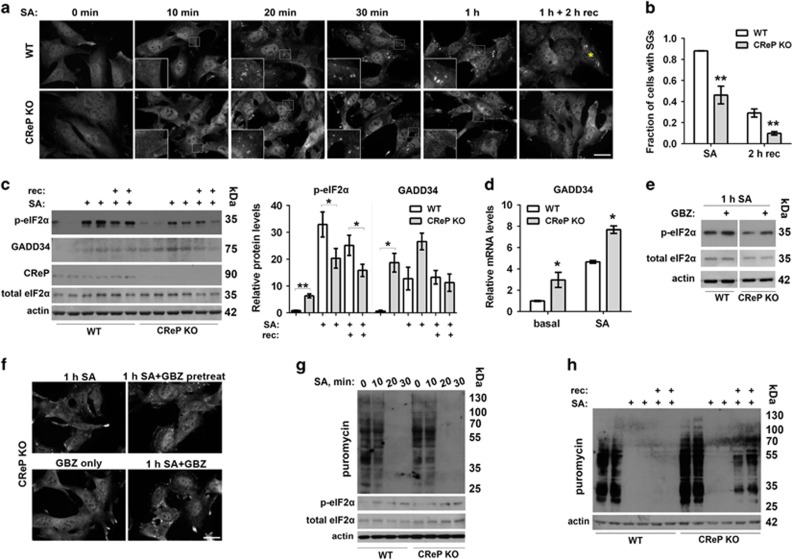
CReP KO MEFs characterized by chronically elevated basal p-eIF2α levels are deficient in SG assembly. (a and b) Initial stages of SG assembly are not affected but SG assembly cannot be maintained through the entire duration of stress in CReP KO cells. WT and CReP KO MEFs were treated with SA for the indicated times. Representative images of TIAR-positive SGs are shown. An asterisk indicates a cell with SGs after 2 h of recovery (a). The fraction of cells with mature SGs was quantified immediately after 1 h of SA and after 2 h of recovery (n=3, **P<0.01) (b). Scale bar, 10 μm. (c) CReP KO MEFs display elevated basal p-eIF2α but fail to maintain high p-eIF2α levels during stress and recovery. Cells were treated with SA for 1 h or left to recover for 30 min after SA wash-off. Representative western blots and band intensity quantification are shown (n=6, *P<0.05, **P<0.01). (d) GADD34 mRNA level is increased in CReP KO MEFs at basal state and after 1 h of SA (n=4, *P<0.05). (e) Guanabenz prevents early decline in p-eIF2α levels post-stress in CReP KO MEFs. WT and CReP KO cells were stressed with SA for 1 h and guanabenz (GBZ, 50 μM) was added together with SA. A representative western blot is shown. (f) Guanabenz rescues SG assembly in CReP KO cells. Cells were pretreated with guanabenz (50 μM) for 30 min before SA addition (1 h SA + GBZ pretreat) or guanabenz was added to the cells together with SA (1 h SA+GBZ). Note that guanabenz alone does not induce SGs. Representative images of all conditions are shown. Scale bar, 10 μm. (g) Shutdown of translation and the build-up of p-eIF2α during SA-induced stress occur normally in CReP KO MEFs. Cells were treated with SA for the indicated times, and newly synthesized proteins were labeled with puromycin and analyzed by western blot. (h) Translational recovery is accelerated in CReP KO fibroblasts. Cells were treated with SA and left to recover for 30 min. Note the appearance of puromycilated proteins in CReP KO cells but not WT cells after 30 min of recovery. In (g and h), representative blots of the experiments repeated three times are shown